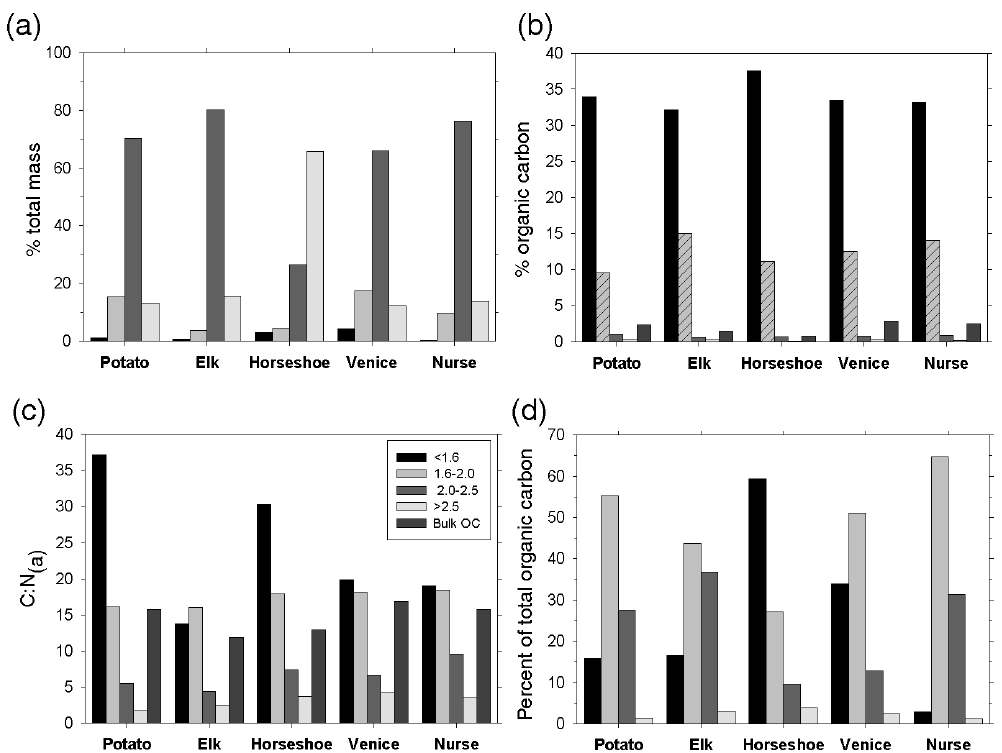
Figure 2. Distributions of (a) mass, (b) organic carbon content, (c) atomic C:N ratio, and (d) percent of total organic carbon for the Delta sediment bulk and density